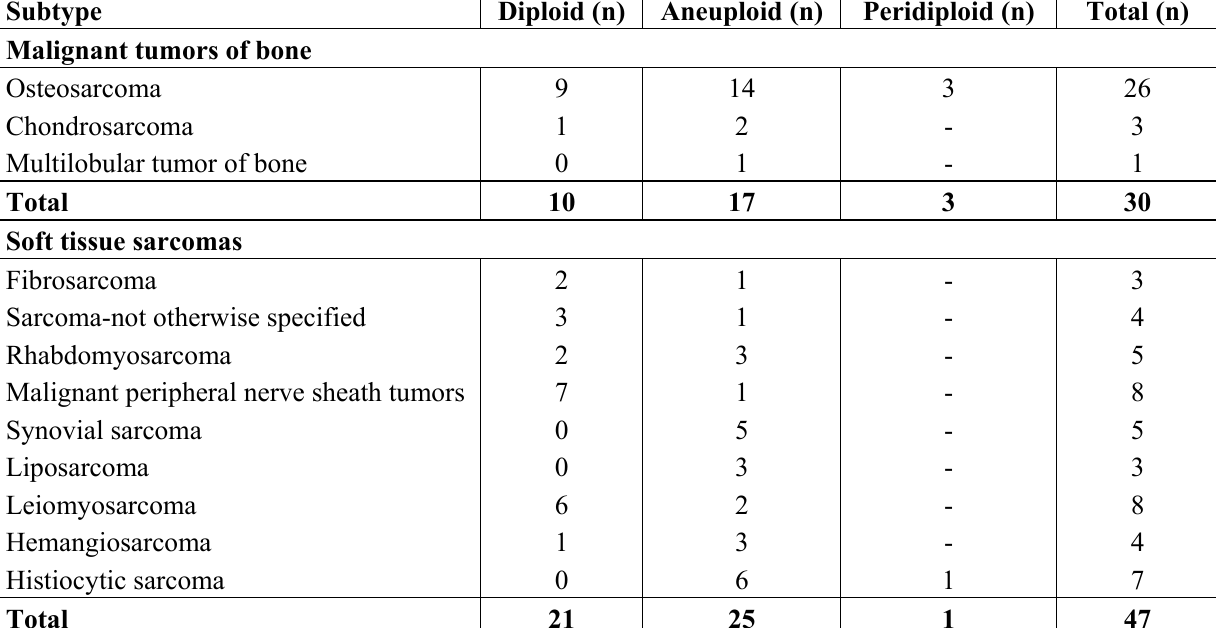
Table 1. DNA-ploidy status in 77 sarcomas according to